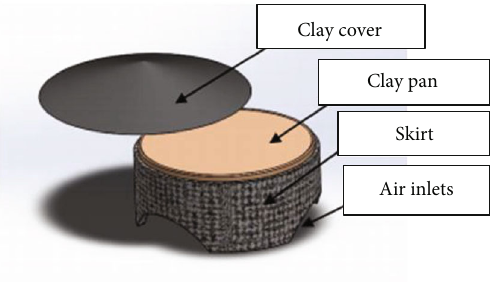
Figure 2: Biogas injera baking stove.